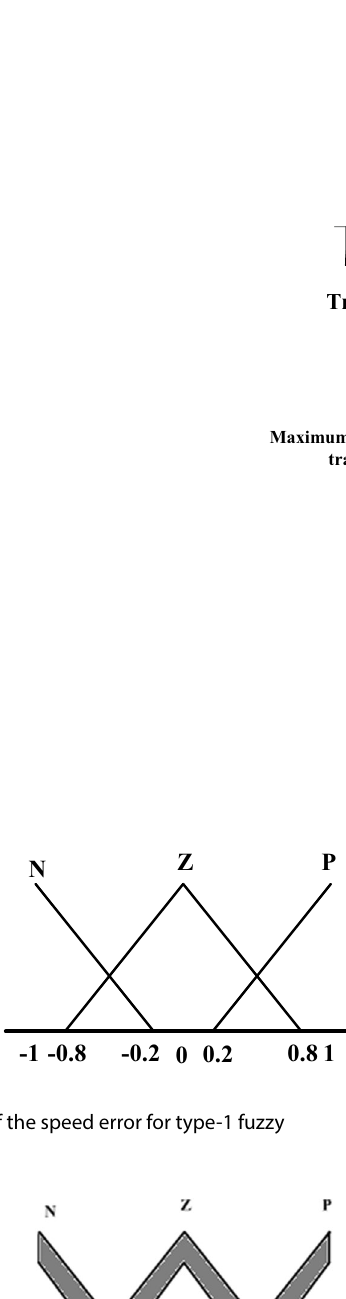
Fig. 6 Control strategy of speed regulator. a conven- tional PI, b interval type-1 FLC tuned PI, c interval type-2 FLC